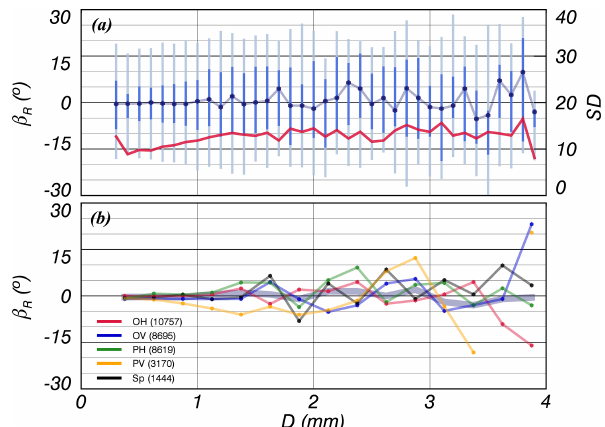
Figure 14. Distribution of β R with D for each particle shape type including the data for all particles. The solid red line indicates the standard